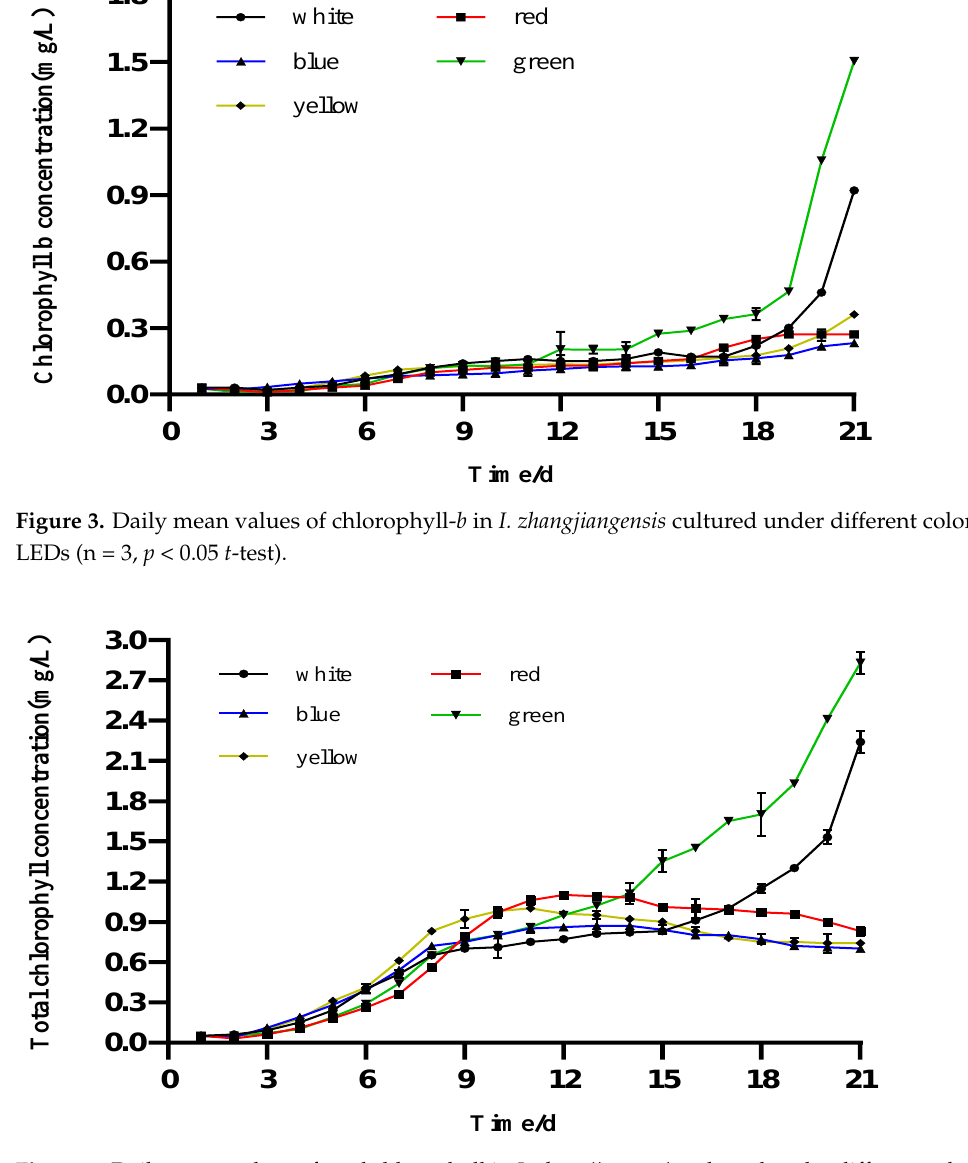
Figure 4. Daily mean values of total chlorophyll in I. zhangjiangensis cultured under different colored LEDs (n = 3, p < 0.05 t